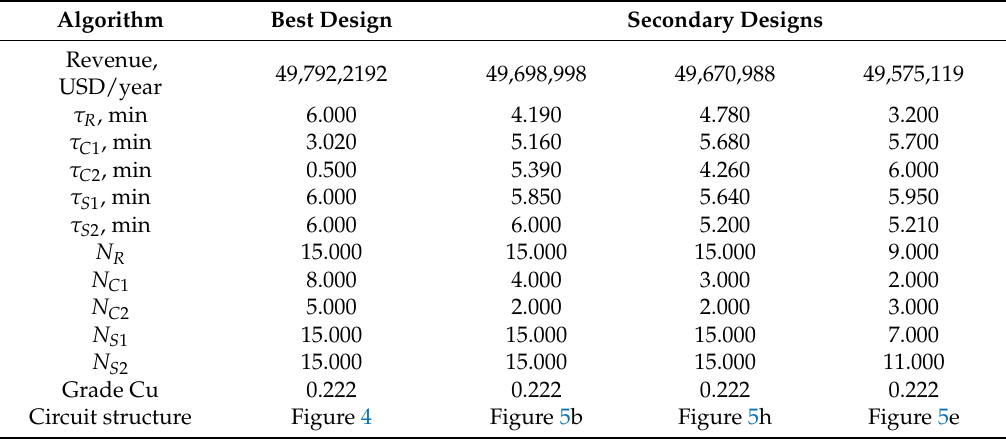
Table 7. Best design and secondary designs provided by the Tabu-search